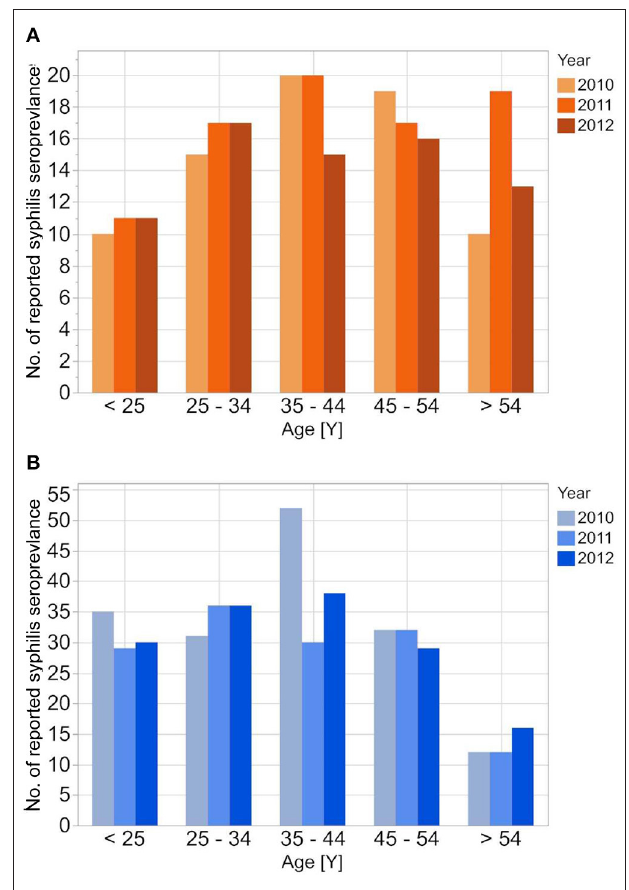
FIGURE 3 | Age stratified reported seroprevalence of syphilis in first time blood donors from 2010 to 2012 for female (A) and male (B)